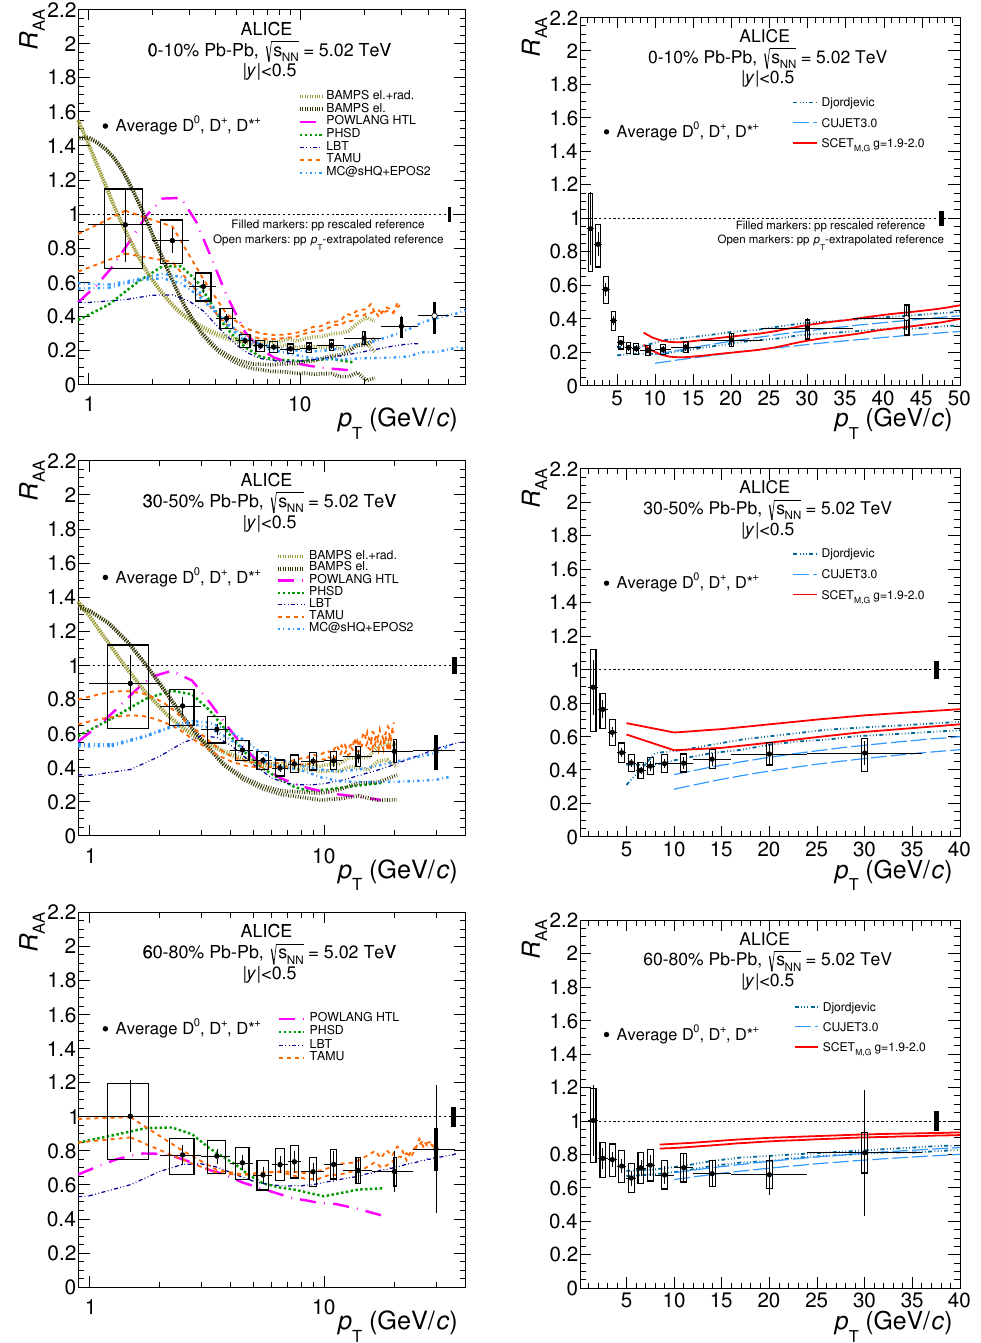
Figure 8 . Average R AA of D 0 , D + and D (cid:3) + mesons compared with model calculations. The three rows refer to the 0{10%, 30{50% and 60{80% centrality classes. The left panels show mod- els based on heavy-quark transport, while the right panels show models based on pQCD energy loss. Model nomenclature and references: BAMPS [57], CUJET3.0 [64], Djordjevic [54], LBT [58], MC@sHQ+EPOS2 [62], PHSD [63] POWLANG [61], SCET [65], TAMU [55]. Some of the models are presented with two lines with the same style and colour, which encompass the model uncer- tainty